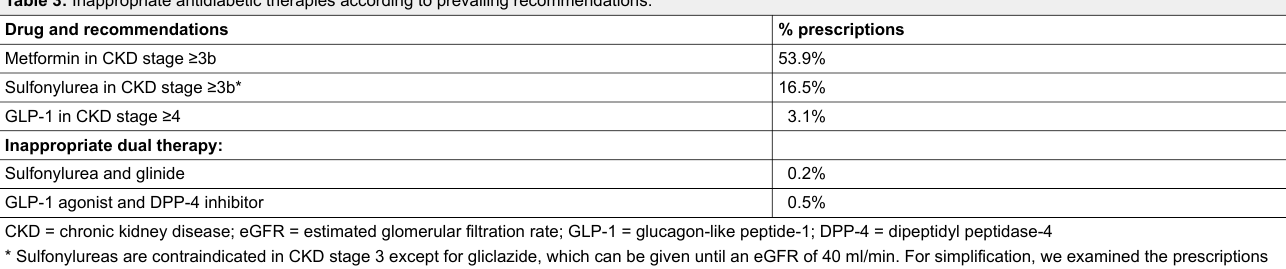
Table 3: Inappropriate antidiabetic therapies according to prevailing